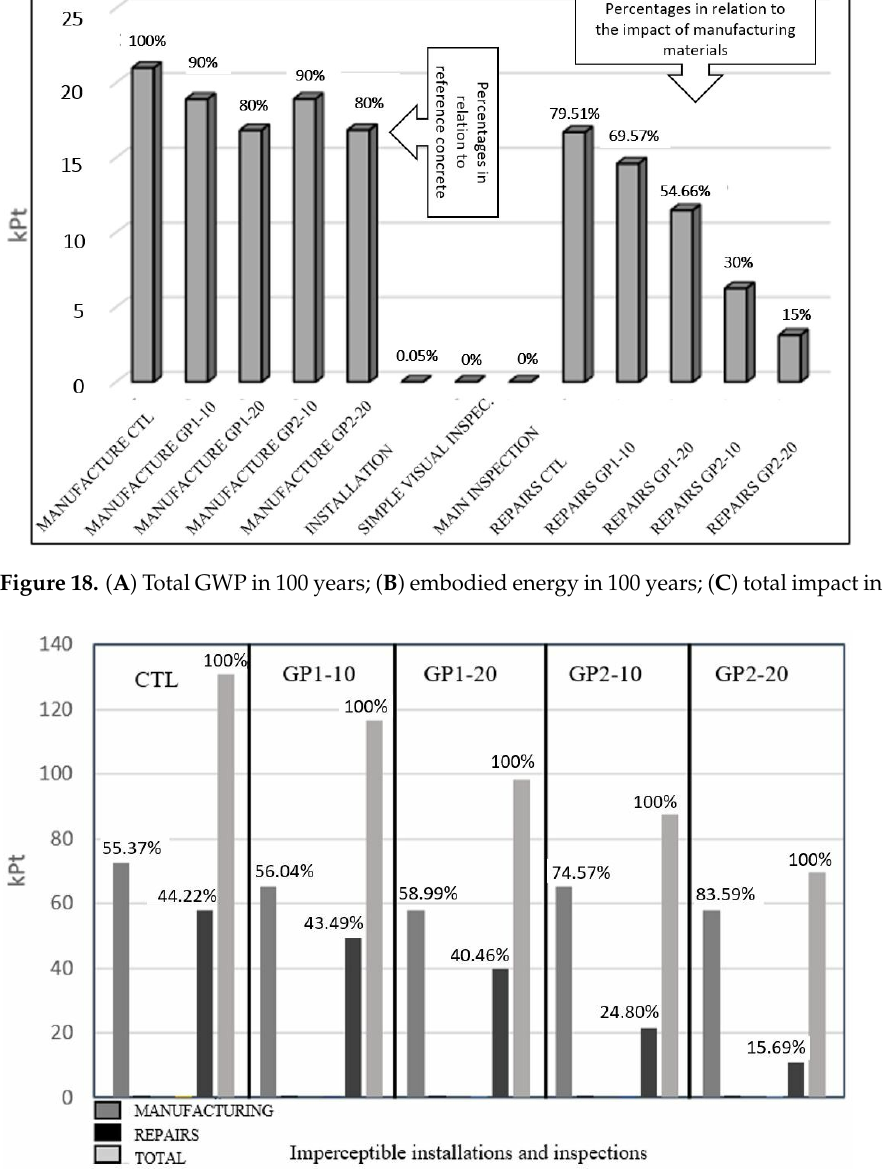
Figure 18. ( a ) Total GWP in 100 years; ( b ) embodied energy in 100 years; ( c ) total impact in 100 years.